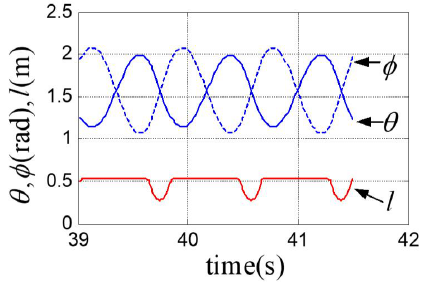
Figure 4. Coordinate trajectories of the robot in a stable hopping orbit.